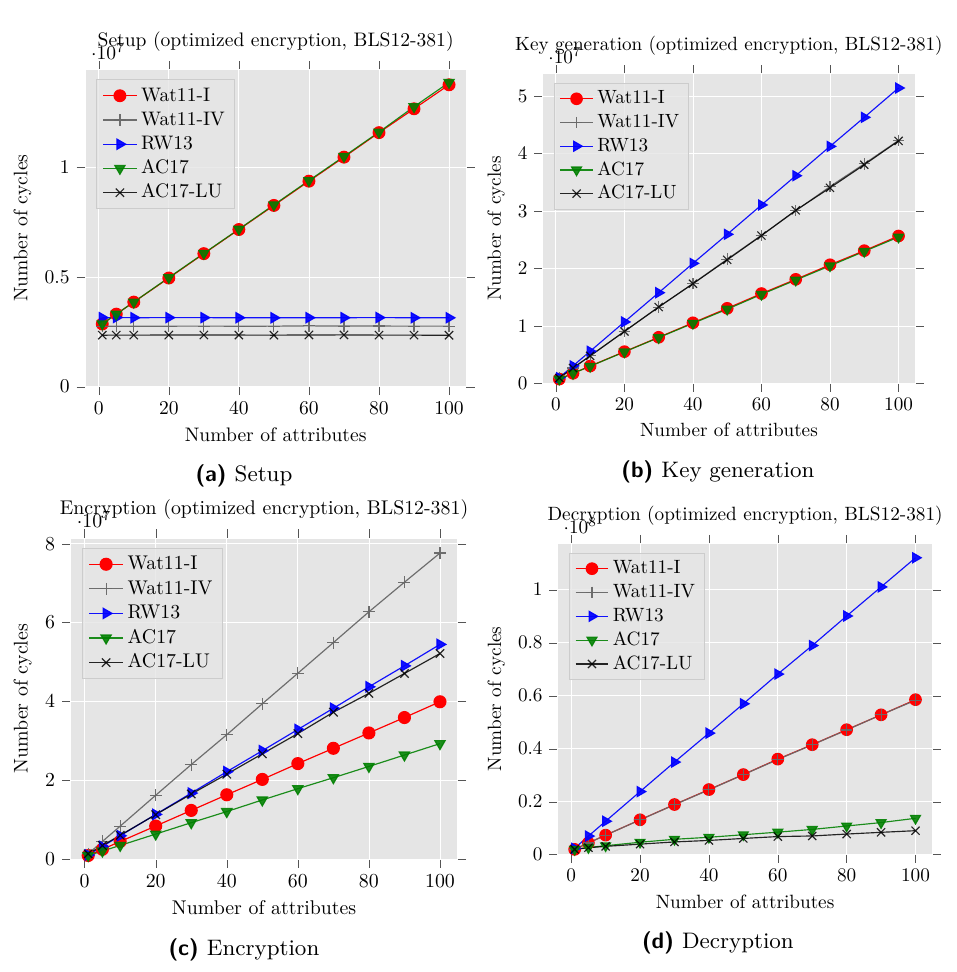
Figure 3: The computational costs in cycles for all the schemes on the BLS12-381 curve, where the schemes are optimized with respect to the encryption